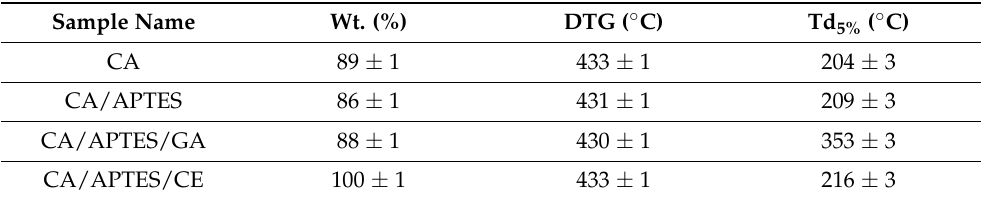
Table 2. The wt (%), Td5%, and the DTG values for the CA membrane, before and after the modifica- tion process. Three different samples were analyzed for calculating the standard deviation.